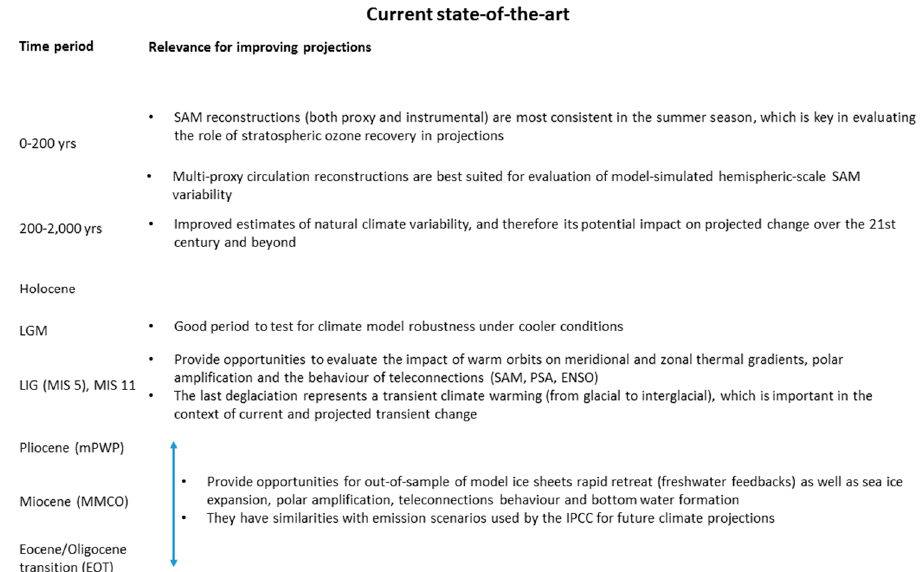
Figure 2. Schematic summarizing the relevance for improving projections from the sections on ‘current state-of-the-art’. Further details on the time periods shown are displayed in Table 1 and Figure 1. The vertical blue lines are used to indicate relevance across a range of time periods.